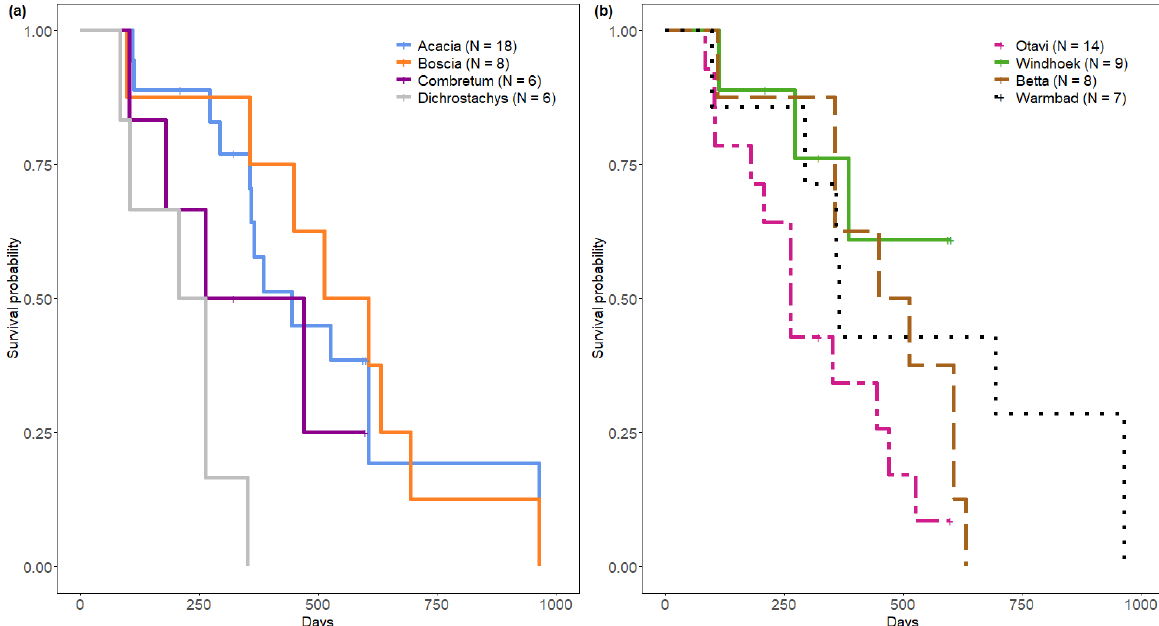
Figure 4. Kaplan Meier survival analysis of Stegodyphus dumicola Pocock, 1898 nests, t0 = sampling start. ( a ) Nest survival per nesting plant genus. ( b ) Nest survival per population. Populations differed in nest survival (log rank test, χ 2 = 8.2, df = 3, p = 0.04). Median